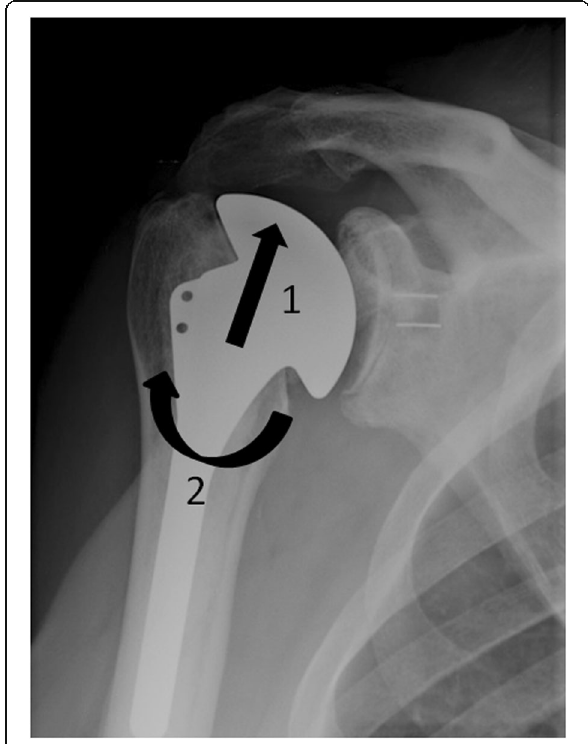
Fig. 15 Anteroposterior shoulder radiograph in a patient with total shoulder prosthesis shows the “ rocking horse ” effect: a superior